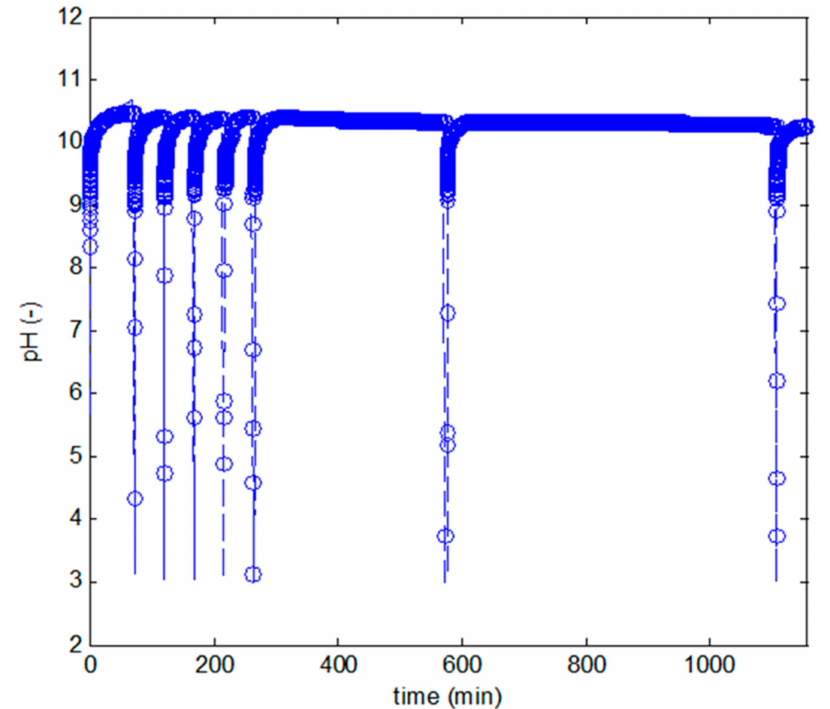
Figure 4. Measured (open circles) and simulated (line) pH responses following acid additions to a 0.04% wt. suspension of 100 nm diameter MgO nanoparticles. Simulations were produced using the mineral dissolution model described in Section